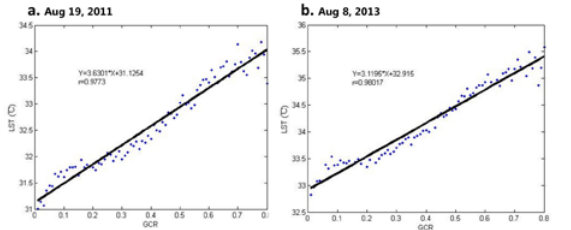
Figure 6. Relationship of mean LST to ground coverage ratio on the condition of GCR < 0.8